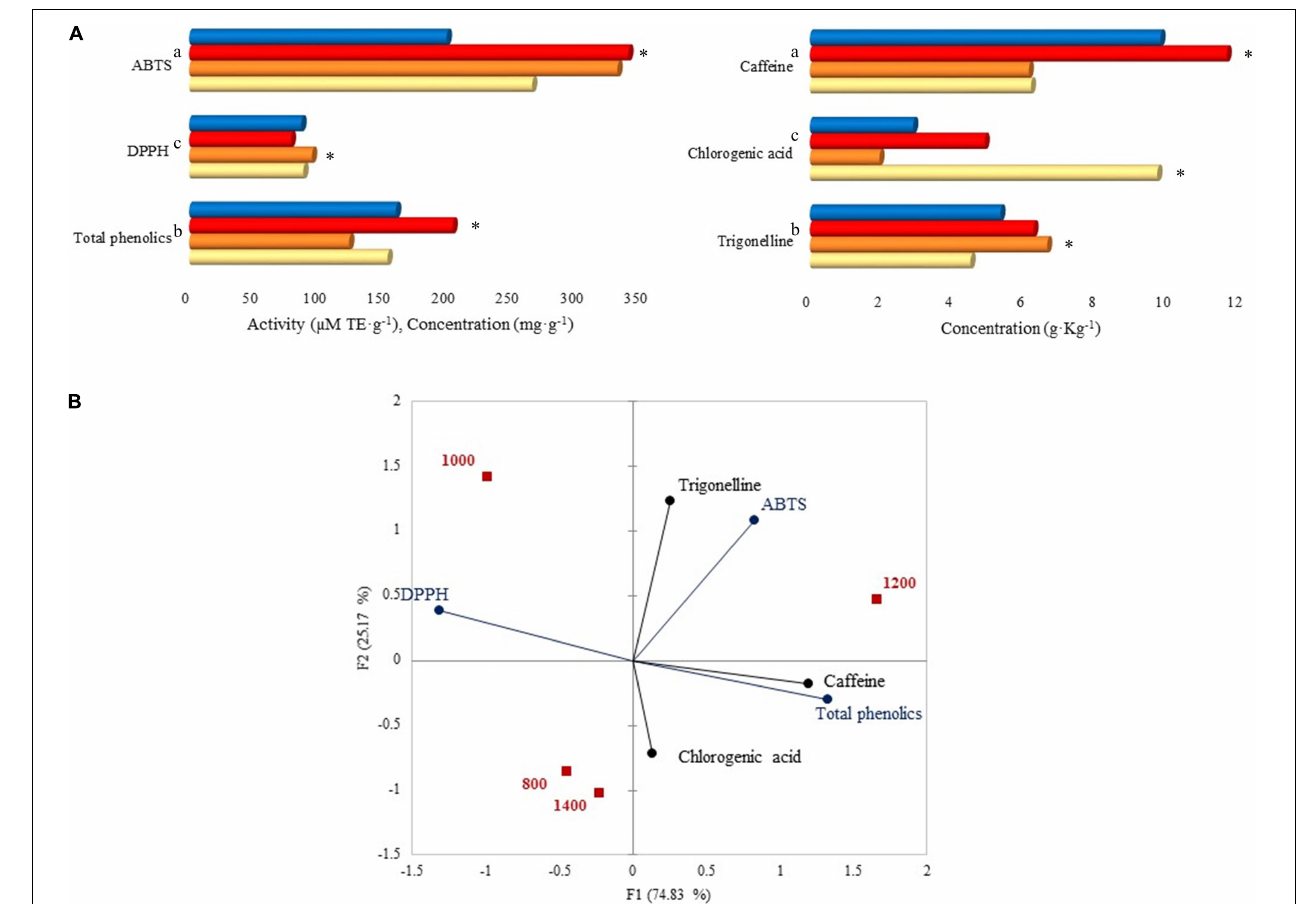
FIGURE 7 | (A) Caffeine, chlorogenic acid, trigonelline, total phenolics concentrations, and antioxidant activity by ABTS and DPPH assays. Each bar represents an altitude: (cid:4) 800, (cid:4) 1,000, (cid:4) 1,200, and (cid:4) 1,400 m. Statistically significant values ( p ≤ 0.05) are represented in letters, from the highest amount to the lowest. ∗ Altitude that was statistically significant ( p ≤ 0.05) and higher in contrast to the other altitudes. Trigonelline, chlorogenic acid, caffeine, total phenolics, DPPH, and ABTS standard deviations: 800 m (1.62, 8.33, 5.21, 0.21, 0, 0.03), 1,000 m (0.78, 0.06, 1.17, 3.72, 0, 21.84), 1,200 m (0.03, 0.01, 0, 3.15, 0, 17.10), 1,400 m (0.08, 0.01, 0.02, 6.60, 0, 0.15). (B) Principal component analysis (PCA) plot of antioxidants, antioxidant activity, and